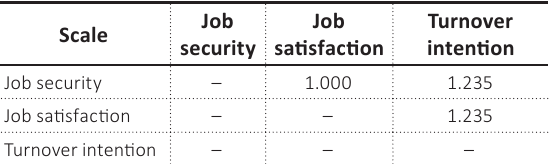
Table 4. Collinearity assessment